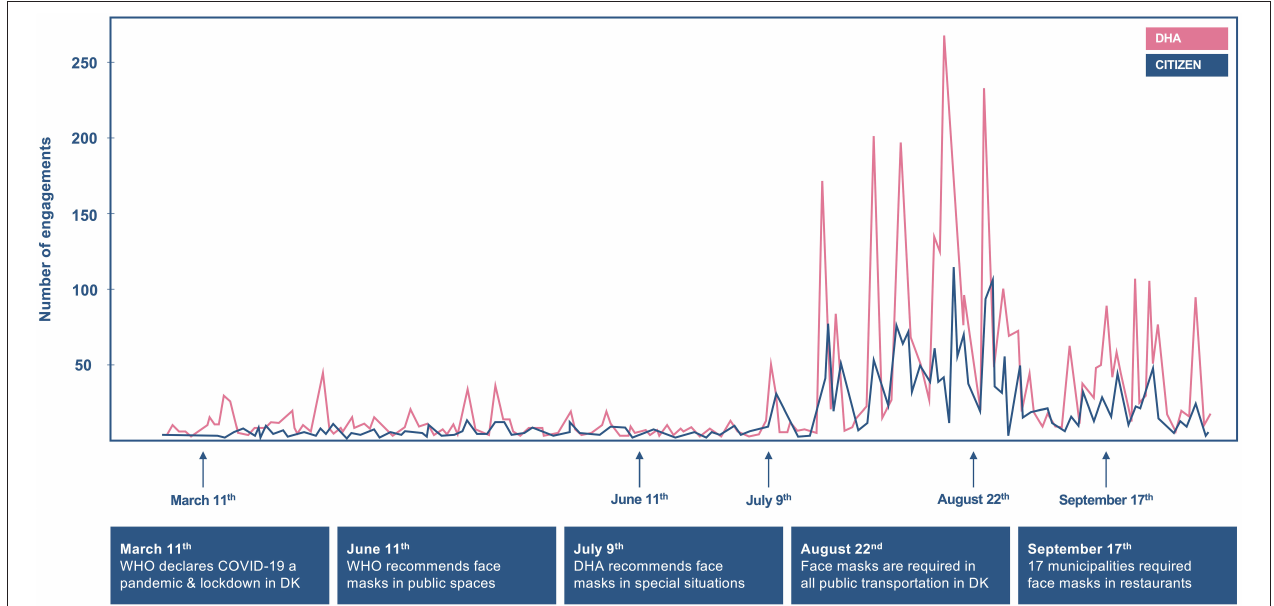
FIGURE 3 | Number of engagements concerning face masks on the Danish Health Authority’s Facebook page, posted by the DHA and by citizens, from March 1st to October 11th